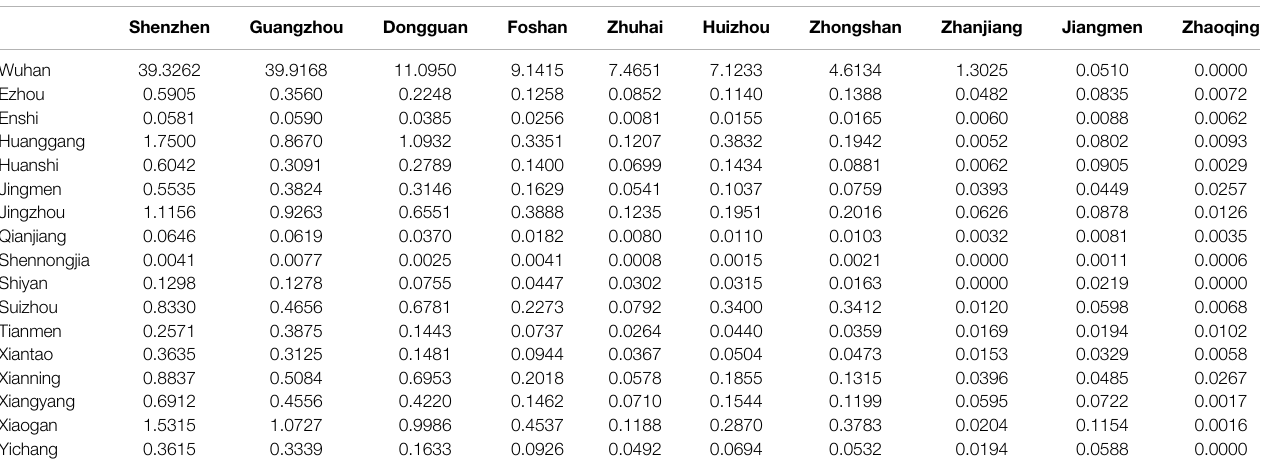
TABLE 2 | COVID-19 infected migrants from each city of Hubei to that of